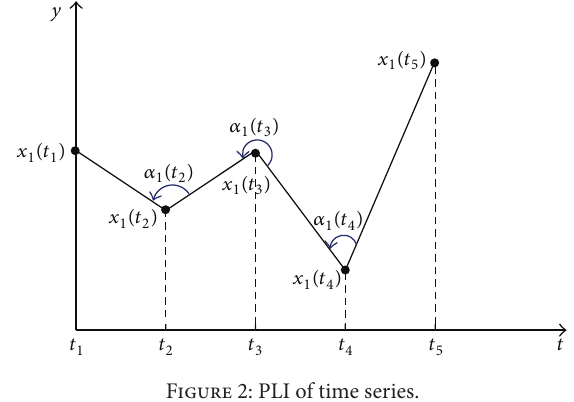
Figure 2: PLI of time